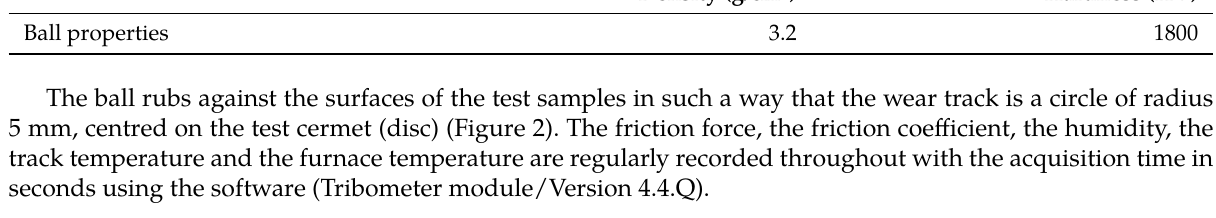
Table 4: Density and hardness properties of an alumina Al